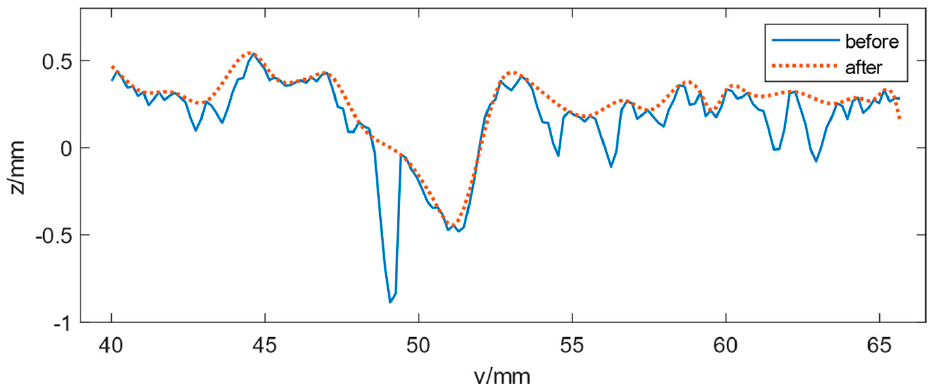
Figure 5. EP of pavement texture (partial). The envelope-processed pavement texture section better characterises the tire-pavement contact, making the subsequent analysis more accurate and meaningful for wear